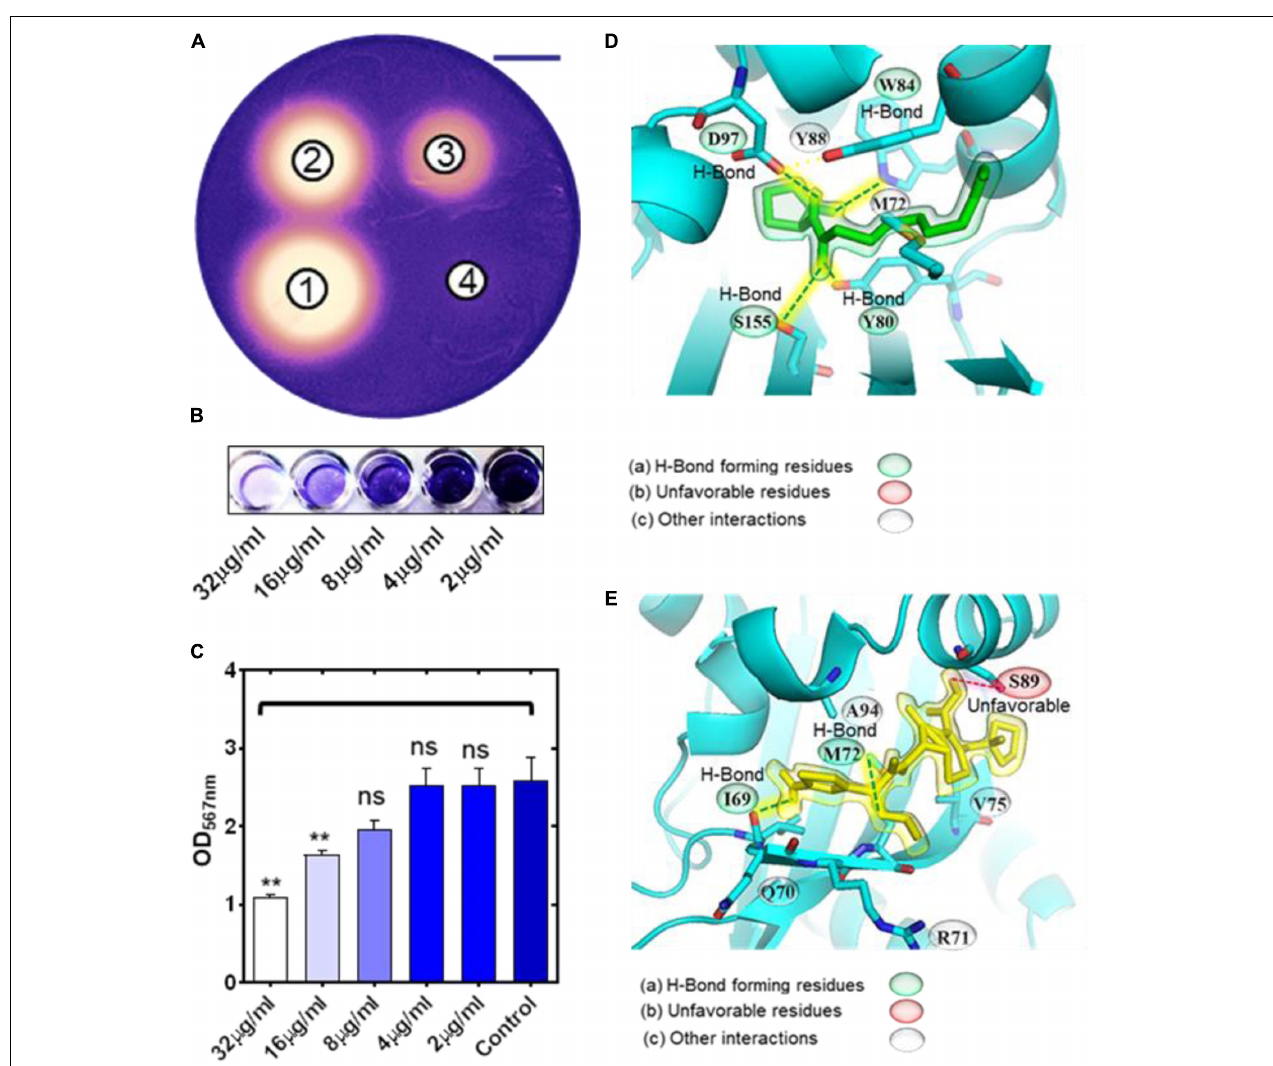
FIGURE 1 | Inhibition of QS in Chromobacterium violaceum CV026 by cephalosporin antibiotics. Photograph of C. violaceum plates showing the zone of growth inhibition and pigment production inhibition (on the edge of the zones) by CP (A) at different concentrations (well-1 = 51.2 µ g; well-2 = 25.6 µ g; well-3 = 12.8 µ g; well-4 = 6.4 µ g) (scale bar = 20 mm). Image of microtiter plate wells (B) and OD 567 nm measurements showing the inhibition of pigment production in 96 well plate assay by sub-inhibitory concentrations of CP (C) . Molecular docking results showing the binding interaction of natural ligand C-10 homoserine lactone molecule (D) , and CP (E) , with CviR receptor of C. violaceum (ns p > 0.05, ** p ≤